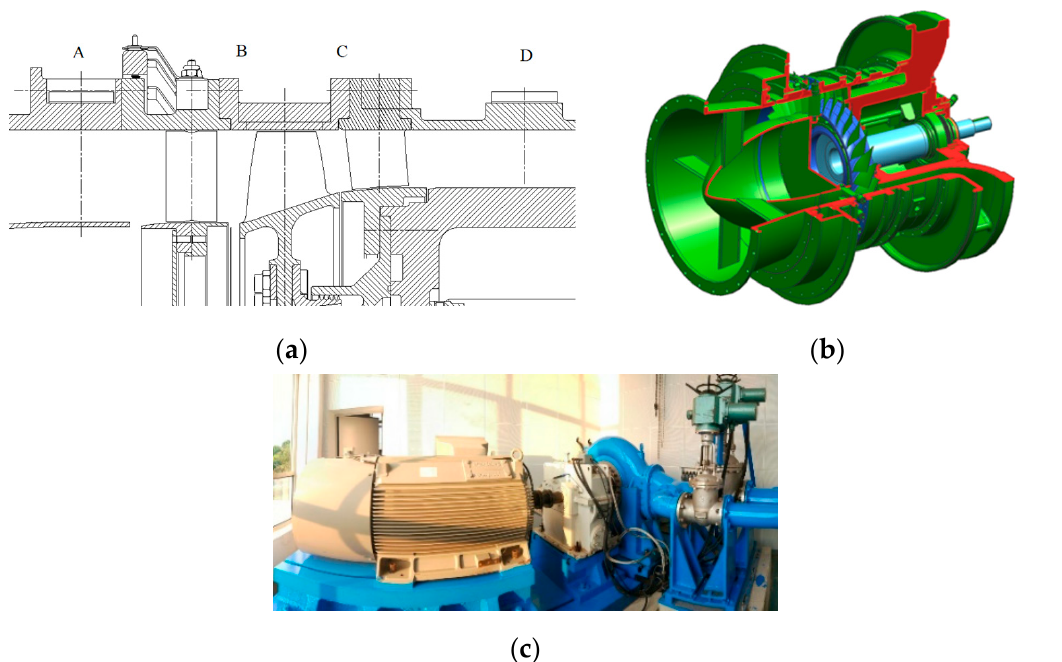
Figure 3. Test facility: ( a ) meridional plane of prototype; ( b ) 3D model of prototype; ( c ) test rig. Table 1. Design parameters of the prototype.